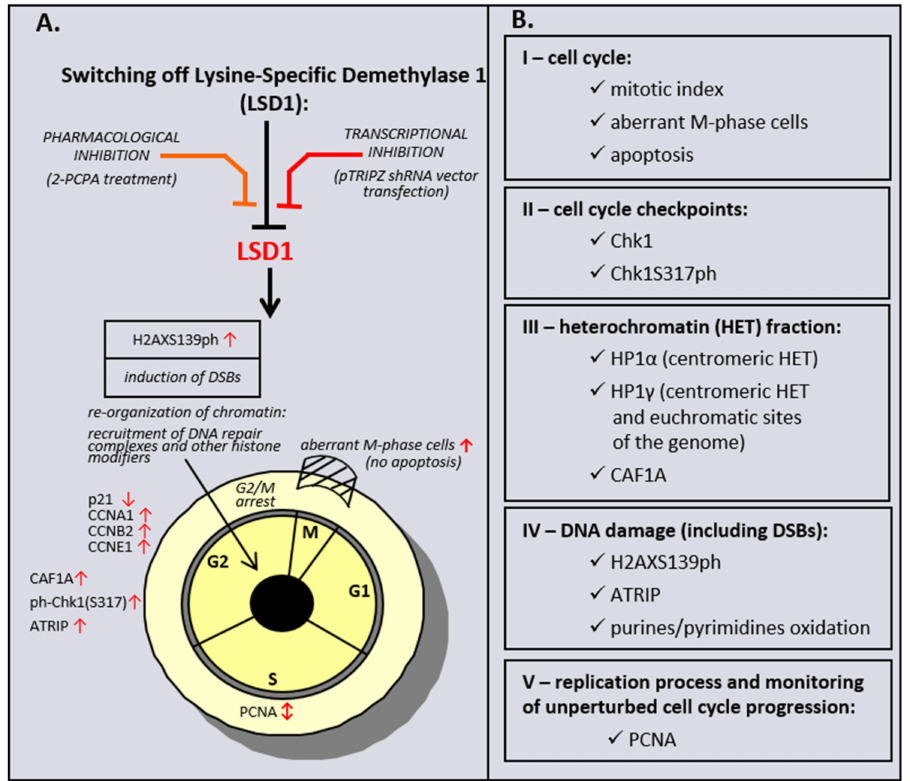
Scheme 1. E ff ect of pharmacological and transcriptional inhibition of lysine-specific demethylase 1 (LSD1) on induction of the cell cycle and DNA damage response (DDR) pathway in microvascular endothelial cells (HMEC-1).